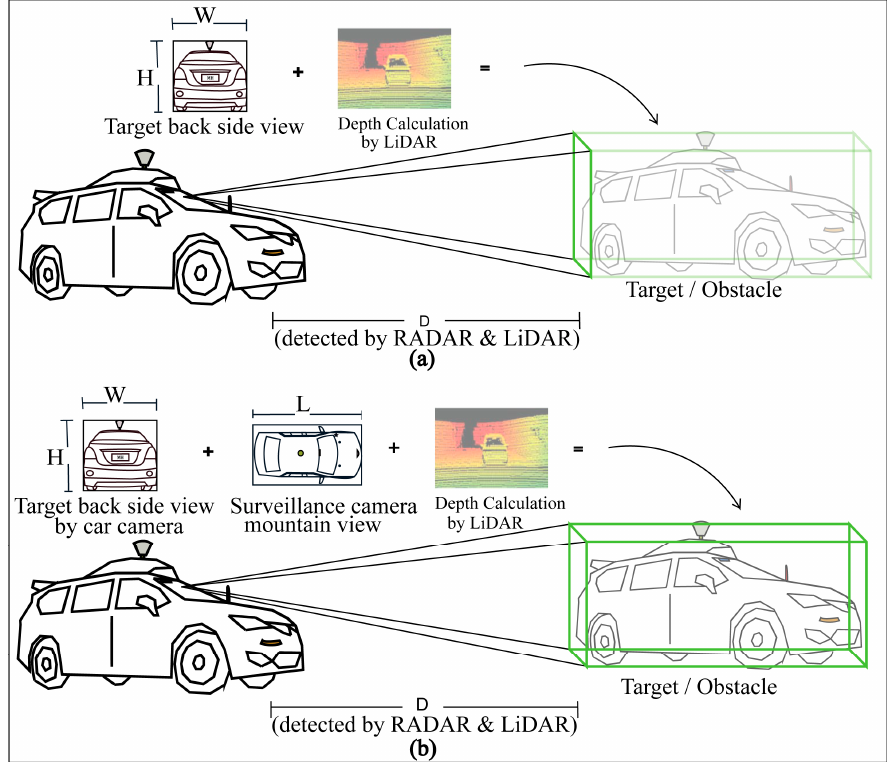
Figure 13. The 3D detection performance analysis: ( a ) 3D approximate partial detections by car sensors, and ( b ) 3D detection improvement with car sensor and surveillance camera view.